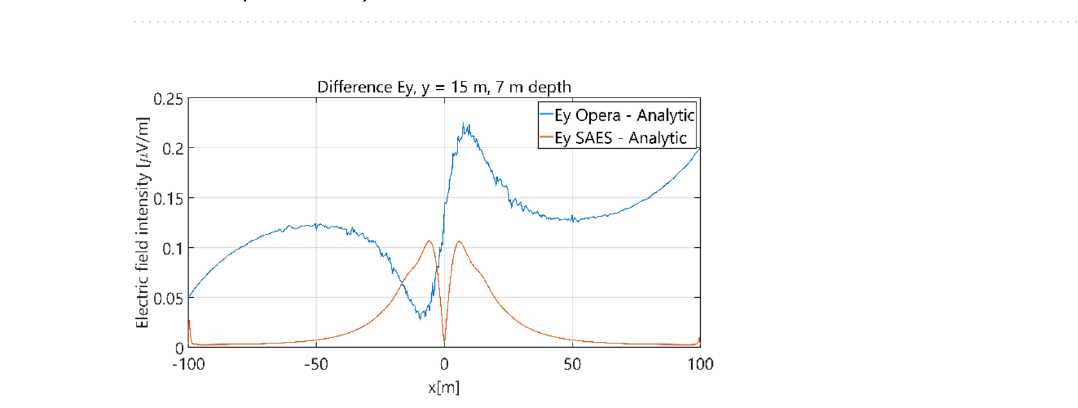
Figure 26. Distribution of differences between E x values obtained from Opera (FEM) and SAES (BEM) models and the analytical model ( y = 15 m, z = − 7 m, case II).